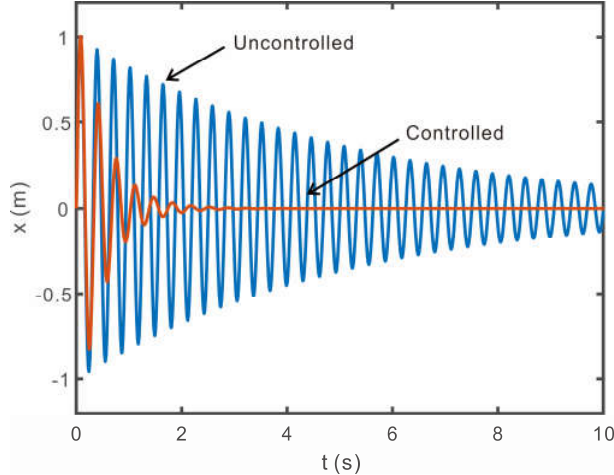
Figure 5. Free vibration simulation.